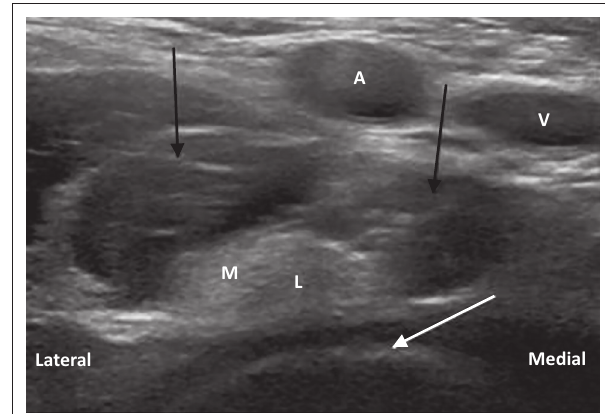
FIGURE 1: Coronal proton density fat saturation (PDFS) image of the pelvis shows a bifid iliopsoas tendon on the right with medial (short black arrows) and lateral (short white arrows) components. The inferior edge of the superior pubic ramus is also shown (long white arrow).